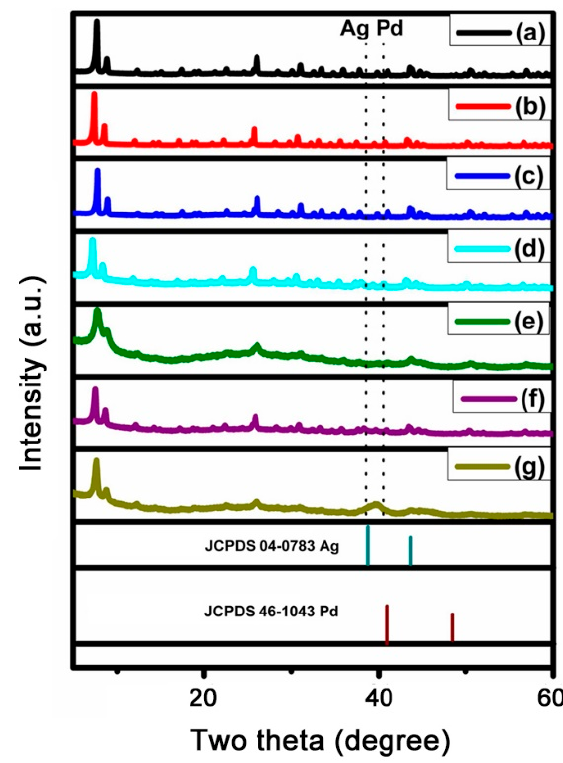
Figure 5. PXRD pattern of UiO-66 ( a ), UiO-66-NH 2 ( b ), UiO-66-NO 2 ( c ), Ag@UiO-66-NH 2 ( d ),